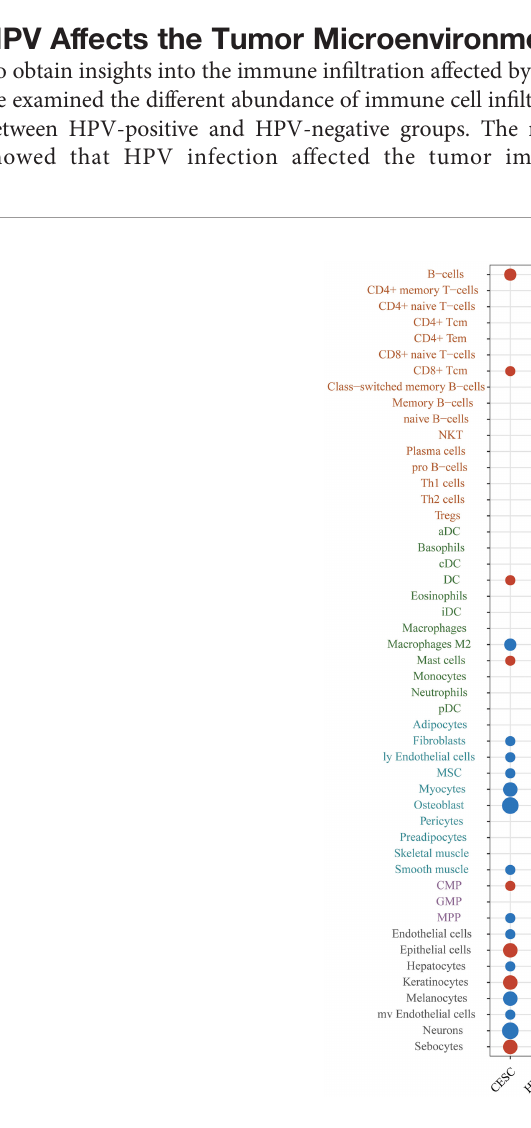
FIGURE 3 | The difference of immune and stroma cell types between the HPV-positive group and HPV-negative group. The red bubbles represent the signi fi cantly upregulated abundance of immune cell in fi ltration, and the blue ones represent that signi fi cantly downregulated. The sizes of the bubbles represent FDR, and different cell types are marked by different colors on the Y-axis label (CESC, cervical squamous cell carcinoma; HNSC, head and neck squamous cell carcinoma; UCEC, uterine corpus endometrial carcinoma; COAD, colon adenocarcinoma; GBM, glioblastoma multiforme; OV, ovarian serous cystadenocarcinoma; ESCA, esophageal carcinoma; STAD, stomach